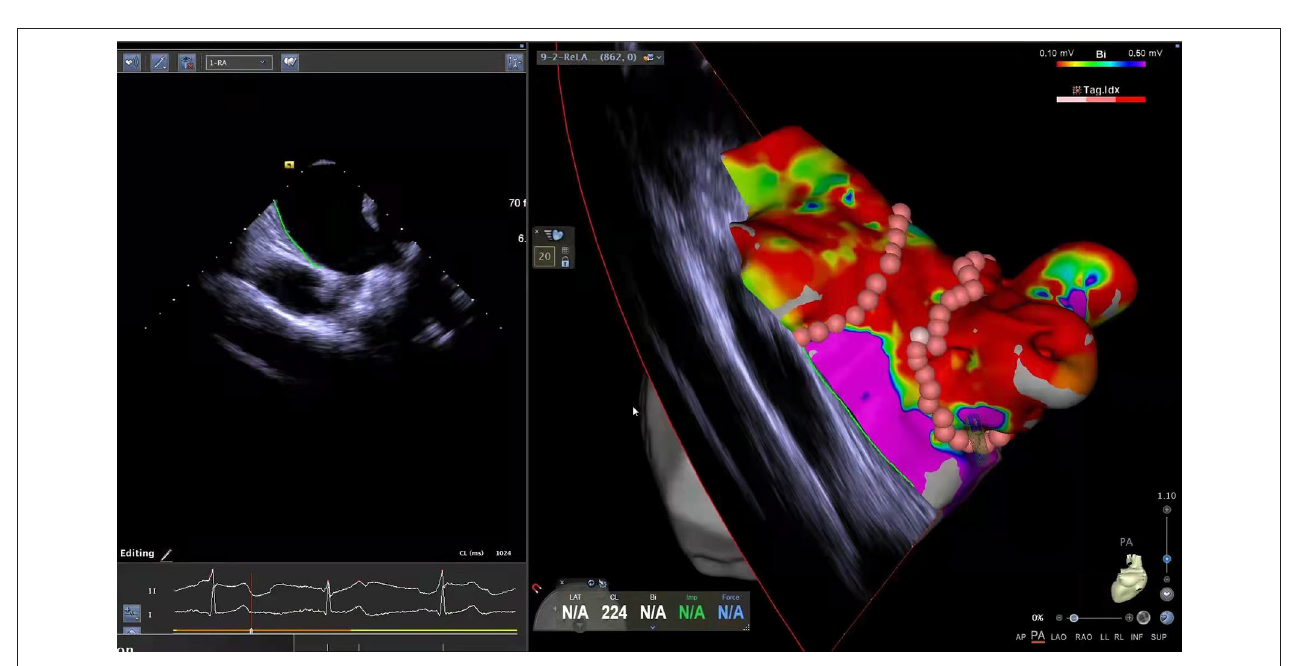
FIGURE 2 | Radio-frequency ablation process